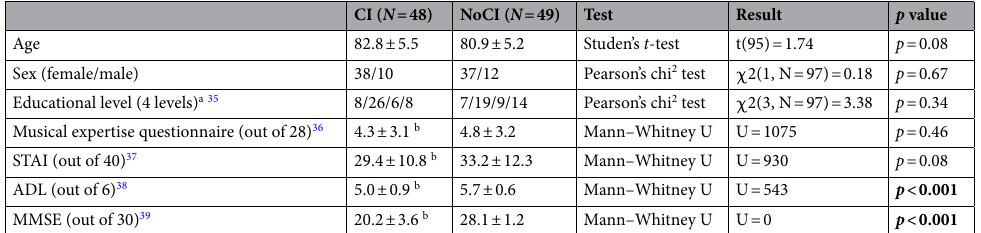
Table 1. Demographic and clinical characteristics of study participants with or without Major cognitive impairment (the CI and NoCI groups, respectively). Data are quoted as the mean ± standard deviation (SD). STAI state-trait anxiety inventory, ADL activities of daily living, MMSE mini mental state examination. a Educational level. Level 1: primary education only; Level 2: junior high diploma; Level 3: high school diploma; Level 4: college diploma. b Missing data for one participant. The p -values of significant statistical tests are in bold.